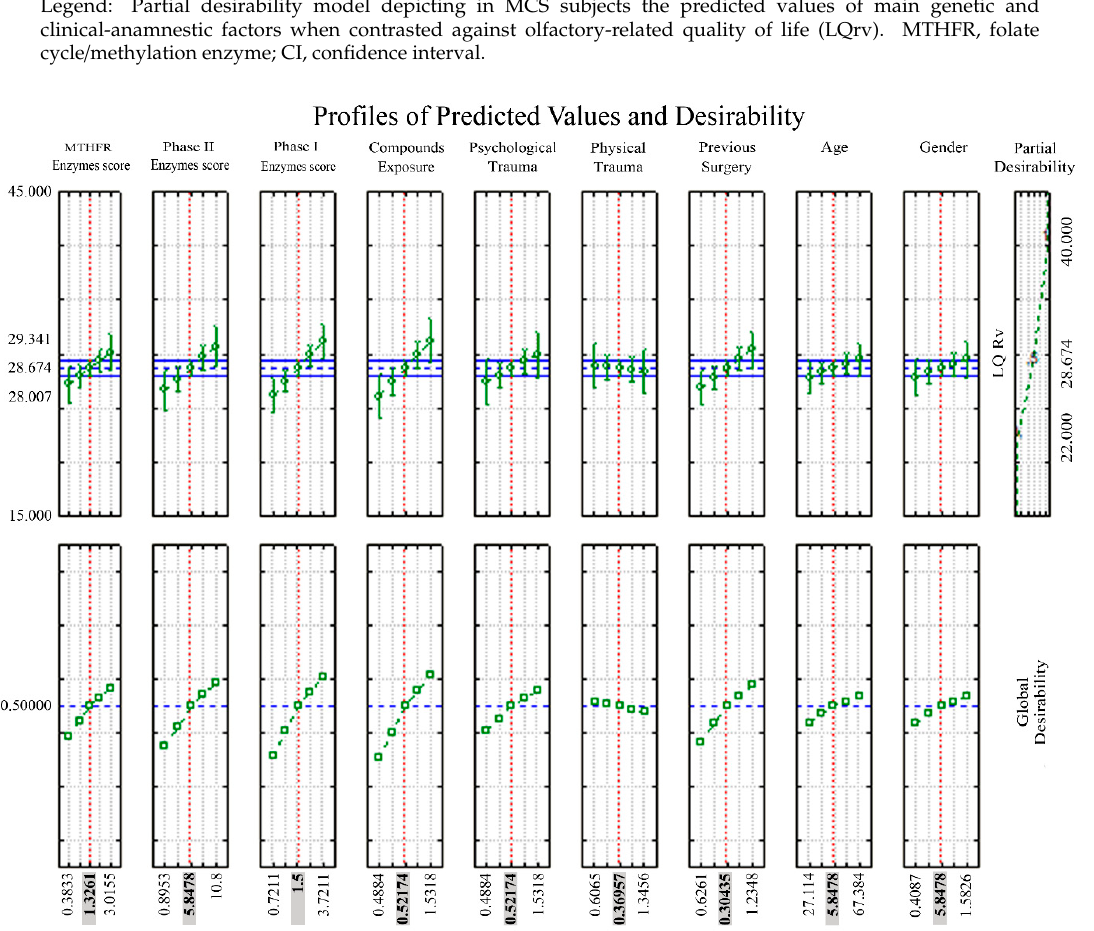
Figure 2. Profiles of predicted values for all coefficients in the desirability model. Plot depicting in MCS subjects the predicted values (bottom squares, grey highlighted) of the main prognostic factors when contrasted against the range included within the upper and lower limits of olfactory-related quality of life score (LQrv) (top squares) in the desirability model.